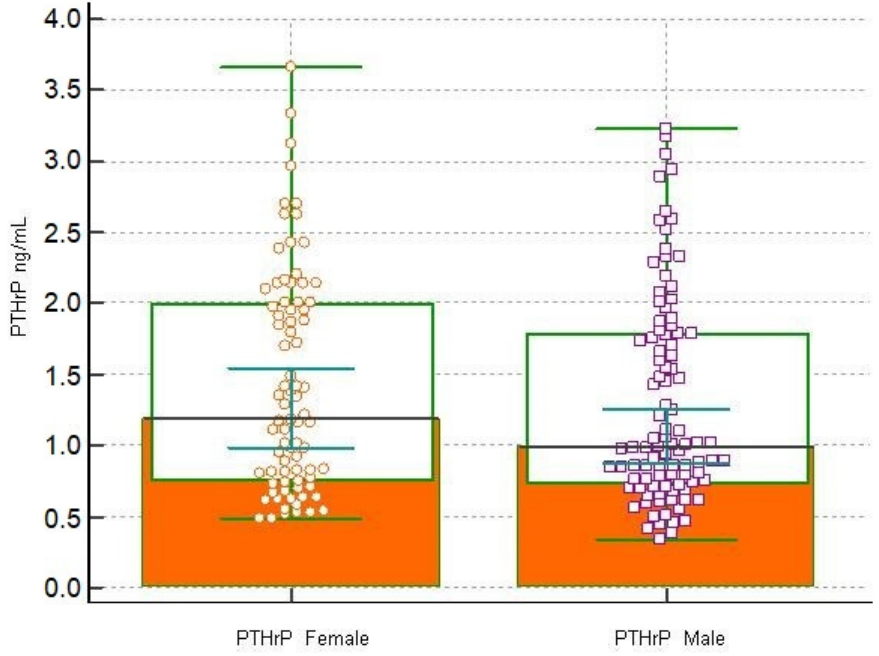
Figure 3. Plot of the scatter diagram of the measurements versus sex (Female and Male). The central box shows the values from the 25th to the 75th quartile, the central line the median, the horizontal lines the extension from the minimum to the maximum value (range).